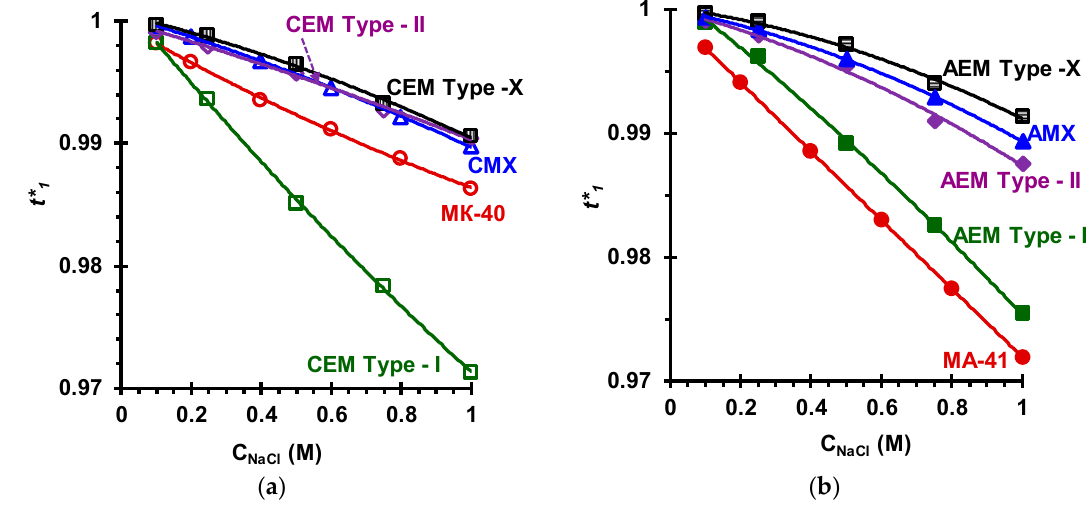
Figure 10. The concentration dependence of the real counterion transport numbers in the cation- ( a ) and anion-exchange ( b ) membranes.